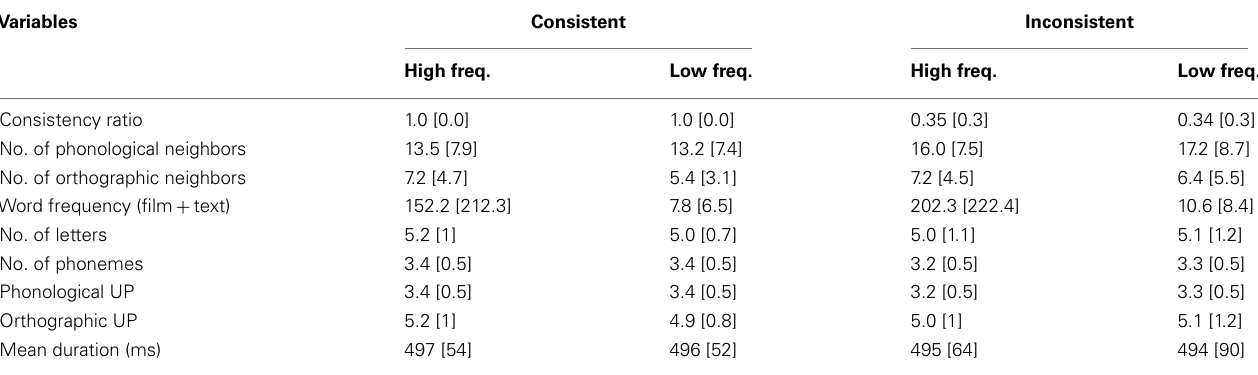
TableA3 | Characteristics of the word stimuli.